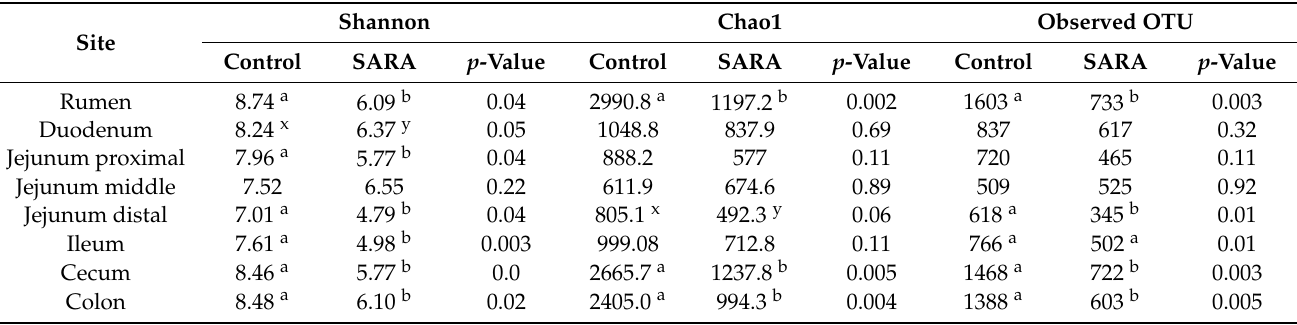
Table 3. Effects of a grain-based SARA challenge (SARA) on bacterial richness and diversity indices throughout the digestive tracts of dairy